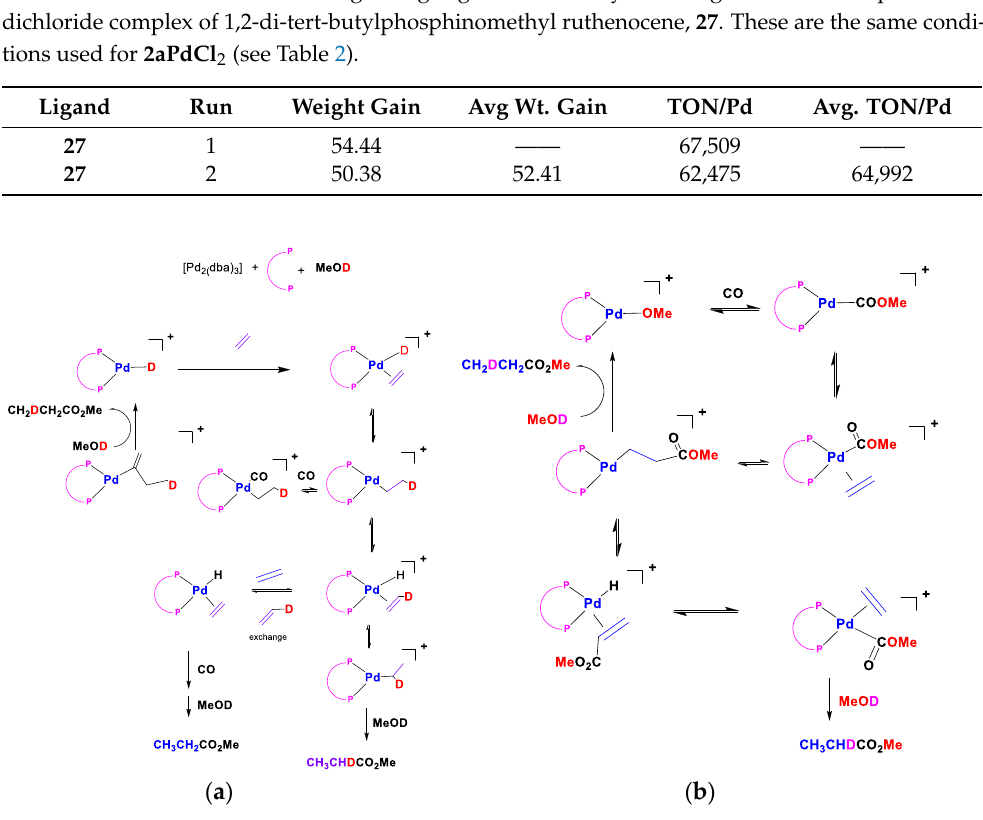
Figure 22. ( a ) The proposed hydride (left) and ( b ) carbomethoxy (right) mechanisms for the formation of methyl propanoate. The palladium complex of ligand 1 catalyses the CO, ethene, and MeOD. (amended from [44,57]).